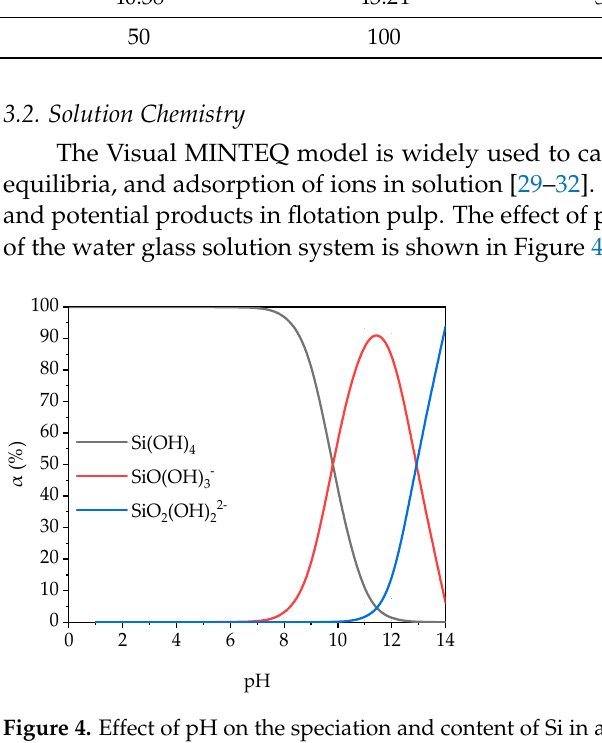
Figure 4. Effect of pH on the speciation and content of Si in a water glass solution.